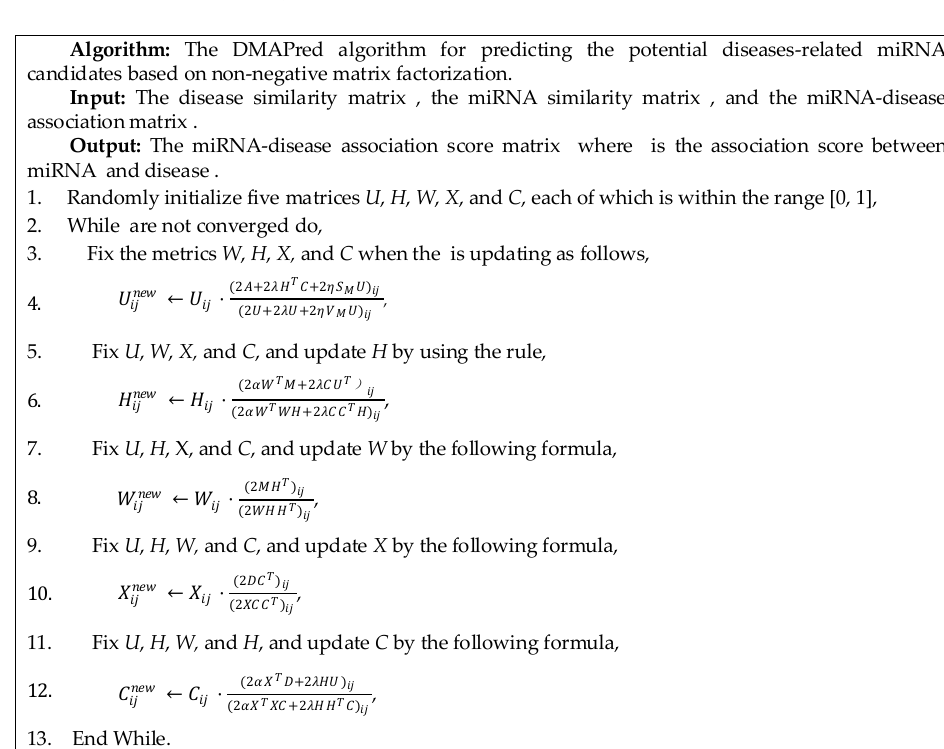
Figure 2. Iterative algorithms for predicting the potential diseases-related miRNA candidates.